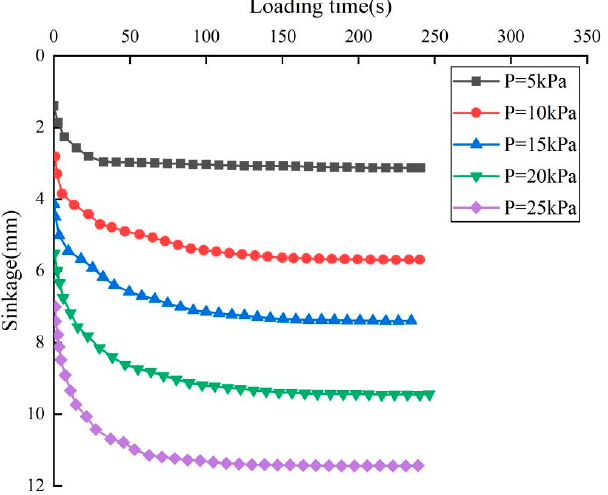
Figure 12. The sinkage–loading time curves of the simulated deep-sea sediments under various ground pressures, according to Xu Feng et al. [26].